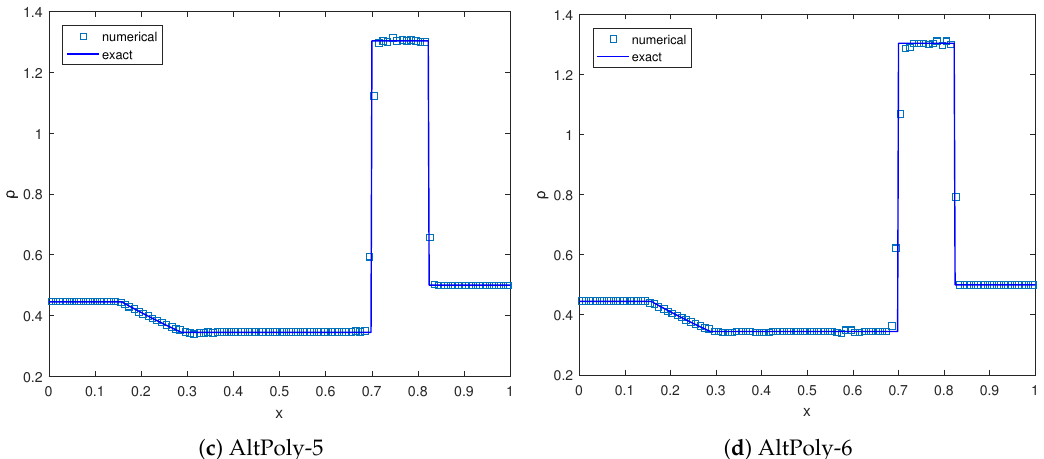
Figure 7. Numerical results of Lax’s problem at t = 0.13 with N = 100 cells. ∆ t = 0.1 ∆ x , 0.1 ∆ x , 0.08 ∆ x , and 0.05 ∆ x , respectively.